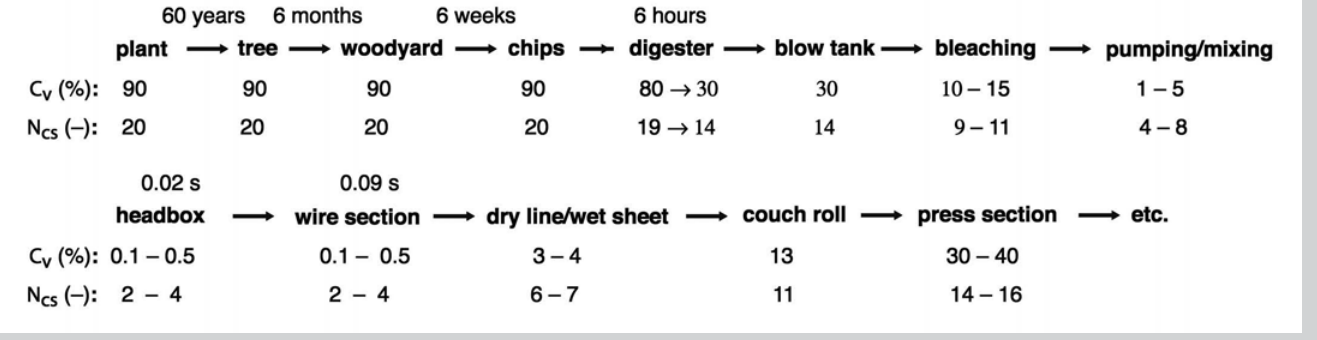
Figure A4: Development of concentra- tion C and fibre centre span v N in the pulp and paper cs